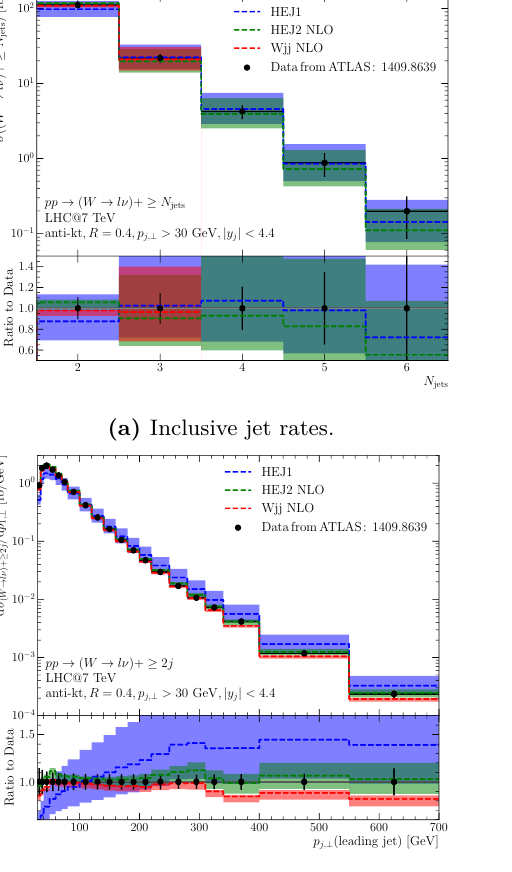
(d) Differential cross section for the transverse momentum of the second leading jet.